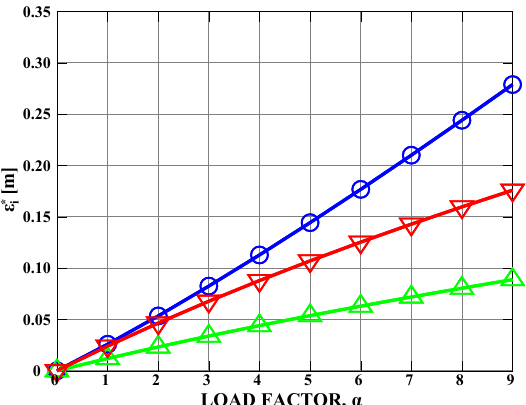
( (cid:13) ), ε ∗ ( 4 ), ε ∗ ( 5 ). Figure 5. Components of the stretch vector: ε ∗ 1 2 3 Proposed deformation measures.